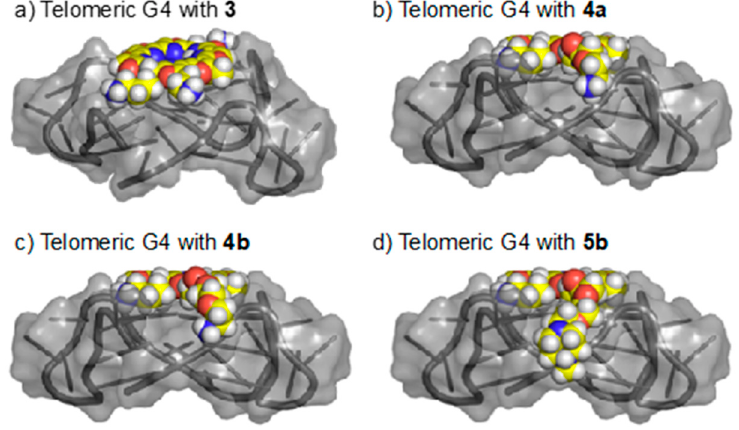
Figure 5. Docking models of parallel-type telomeric G4 with compounds ( a ) 3 , ( b , c ) 4 , and ( d ) 5b